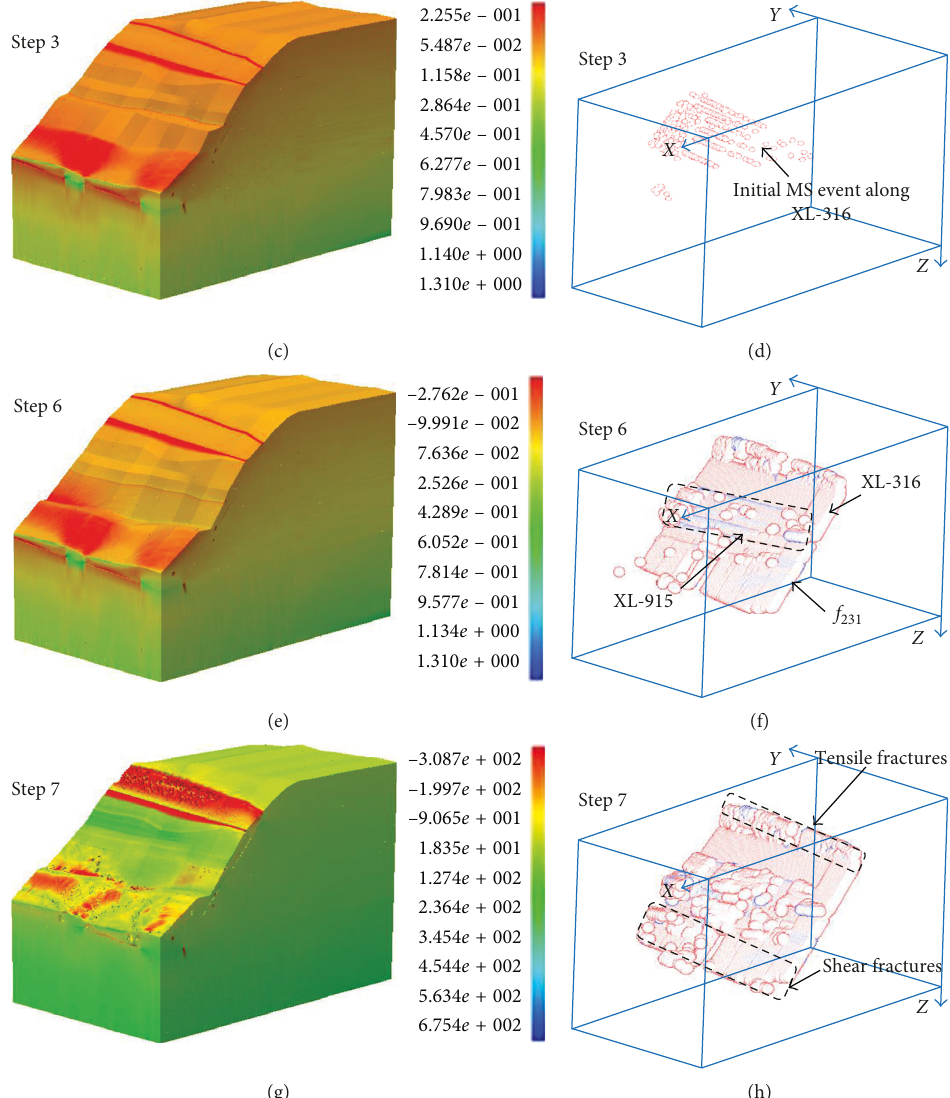
Figure 15: Distribution of the minimum principal stress (a, c, e, g) and AE (b, d, f, h) during the progressive failure